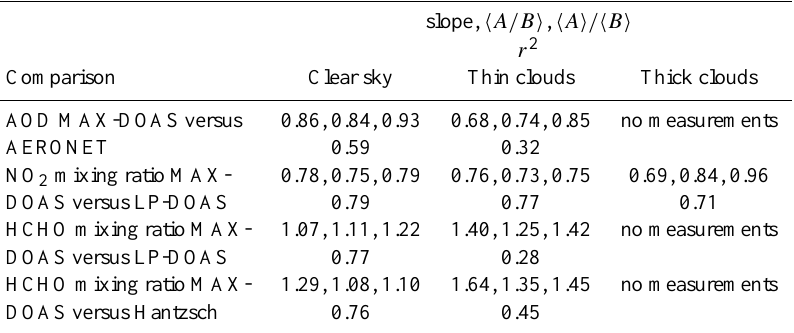
Table 5. Comparison results of MAX-DOAS observations and independent measurements for different cloud cover for the southern telescope (4 September to 26 September, see text). Besides the slopes of the fitted regression line, the mean value of the individual ratios h A/B i the ratio of the mean values h A i / h B i (see Eqs. 20 and 21) and the coefficient of determination, r 2 , are